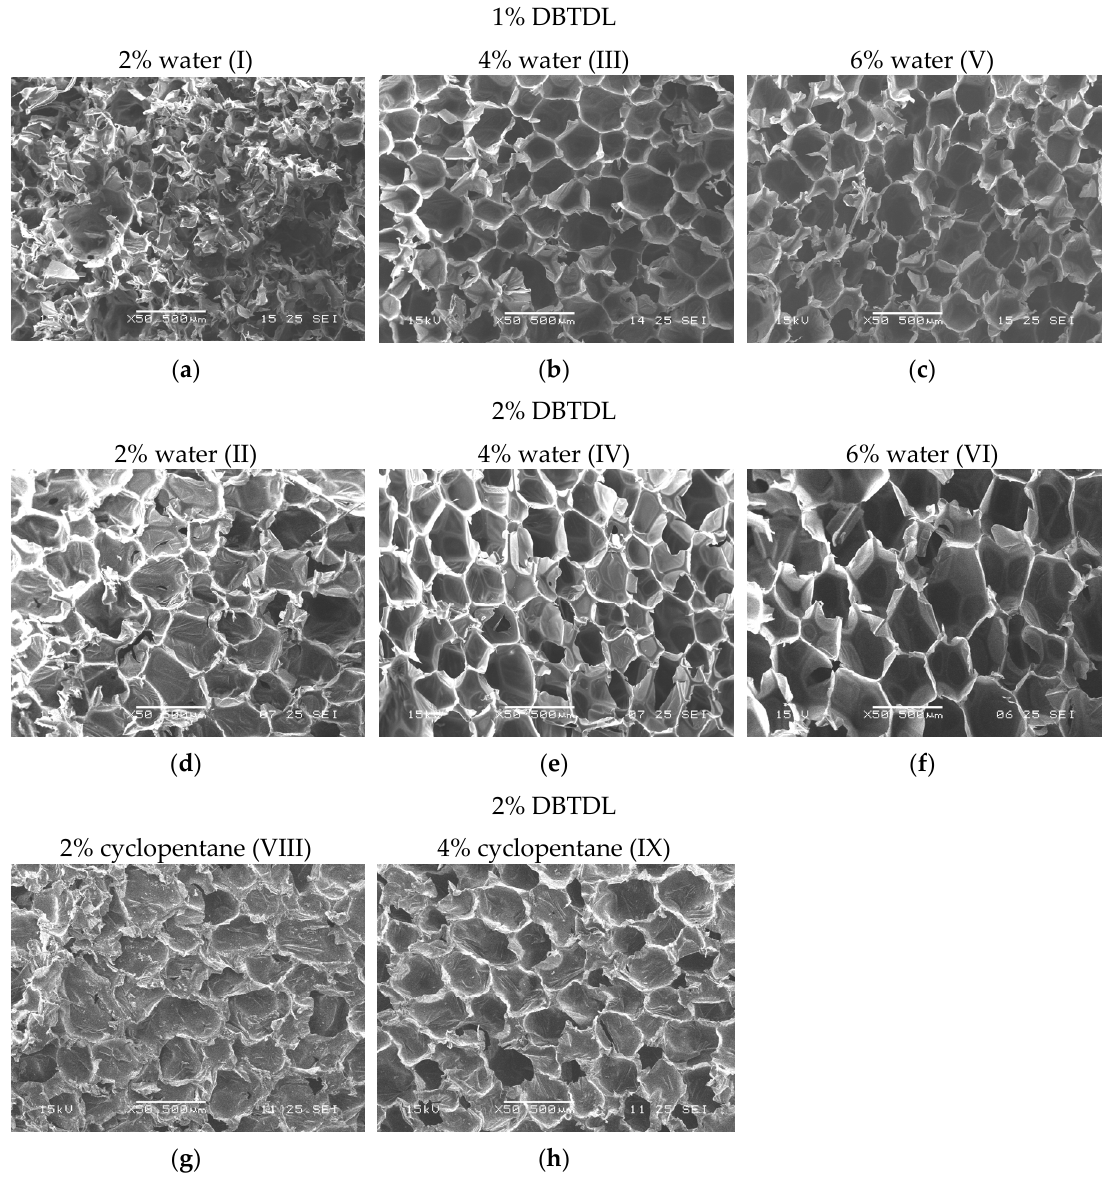
Figure 6. SEM micrographs of GCo foams with different types and contents of blowing agents and catalyst DBTDL (scale bar of 500 μ m 50×). The numbers of the foam formulations (Table 1) are indicated in each micrograph.